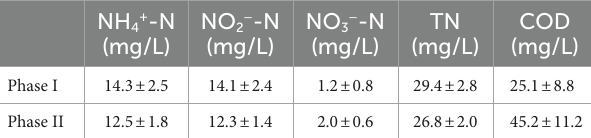
TABLE 1 Main characteristics of the influent of the mainstream anammox